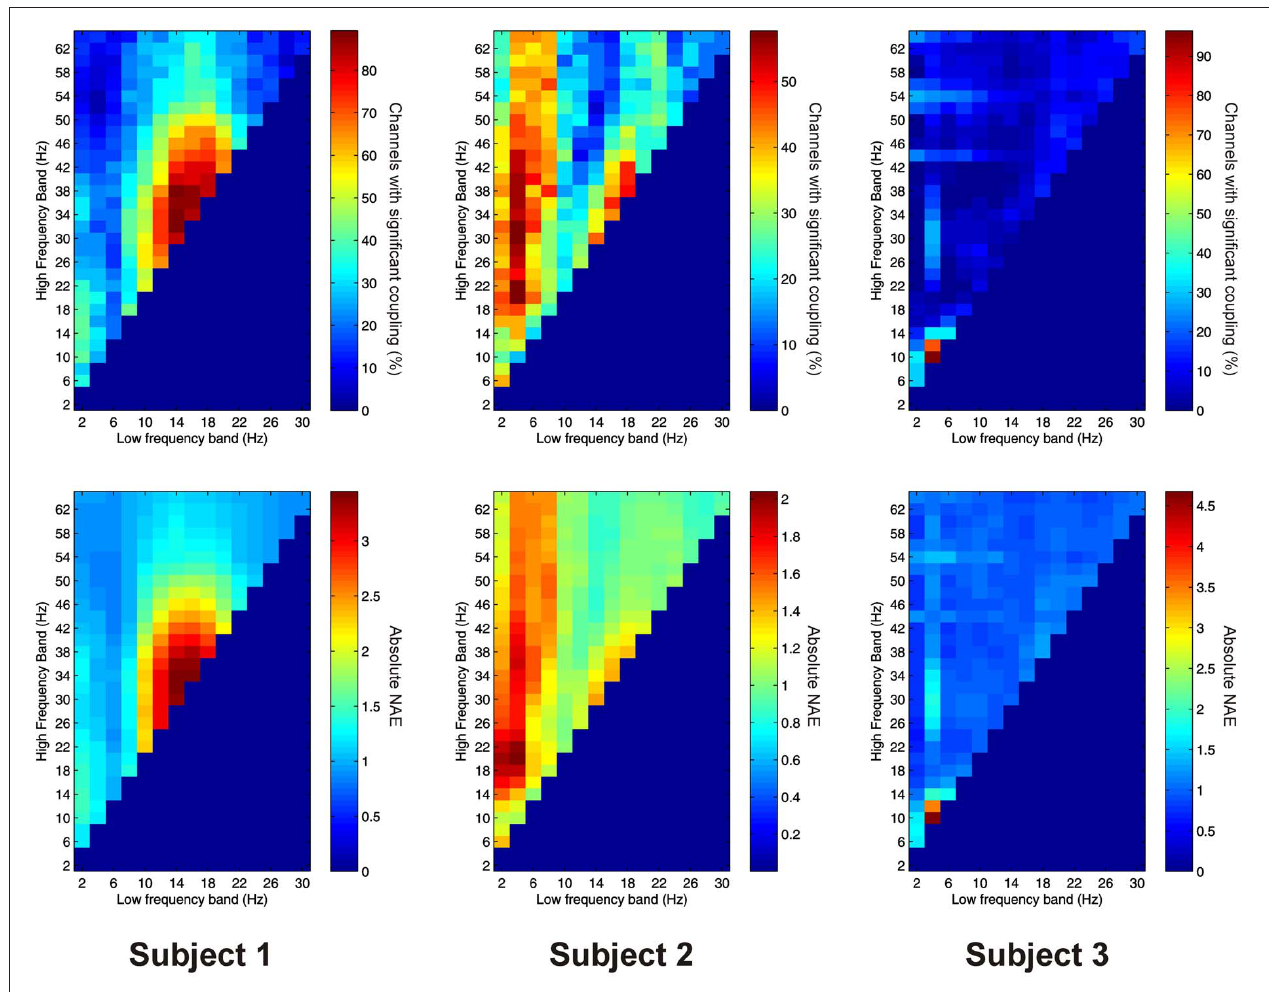
FIGURE 7 | Top row: Proportion of channels showing significant thalamo-cortical AAC (coupling between a low-frequency in the thalamus and a high-frequency in the cortex) (Subject 1 left, Subject 2 middle, Subject 3